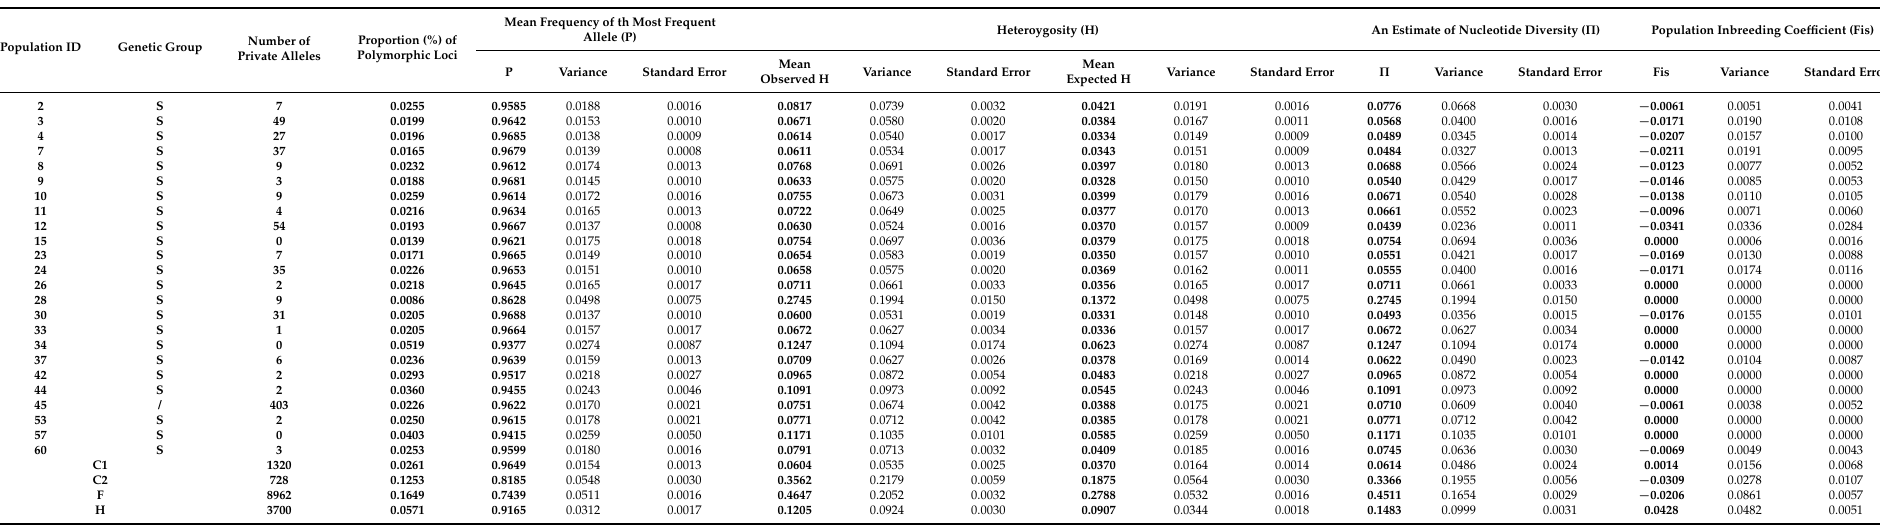
Table 3. Population characteristics calculated on the basis of analysis of ddRADseq sequence data. The displayed characteristics are calculated for each population of the S group and for groups C1, C2, F and